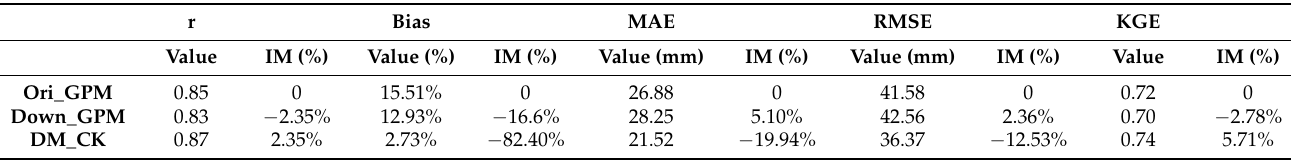
Table 4. Evaluation for quantitative indices of the Ori_GPM, Down_GPM, and DM_CK for monthly precipitation estimates from March 2016 to February 2018.